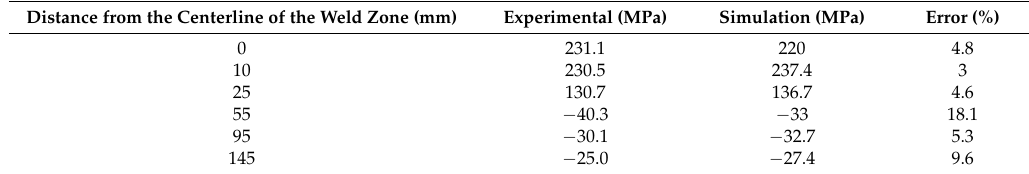
Table 6. Values of the principal stresses in X direction obtained from simulation and